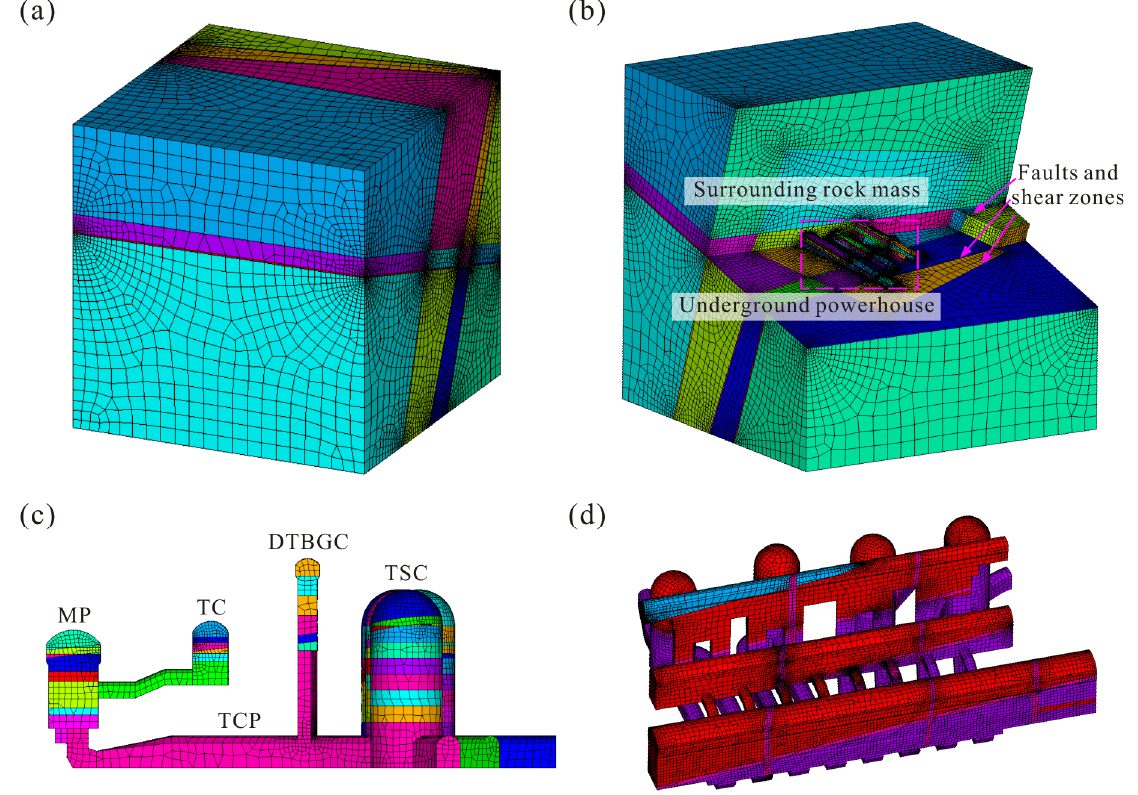
Figure 7. Numerical model: ( a ) outside of the model, ( b ) main components of the model, ( c ) a side view of the underground powerhouse and ( d ) a three-dimensional diagram of the underground powerhouse. MP, TC, DTBGC, TSC and TCP are abbreviations for the main powerhouse, trans- former chamber, draft tube bulkhead gate chamber, tailrace surge chamber and tailrace connection pipe, respectively. Table 1. Mechanical parameters of the surrounding rock masses used for the numerical simulation.